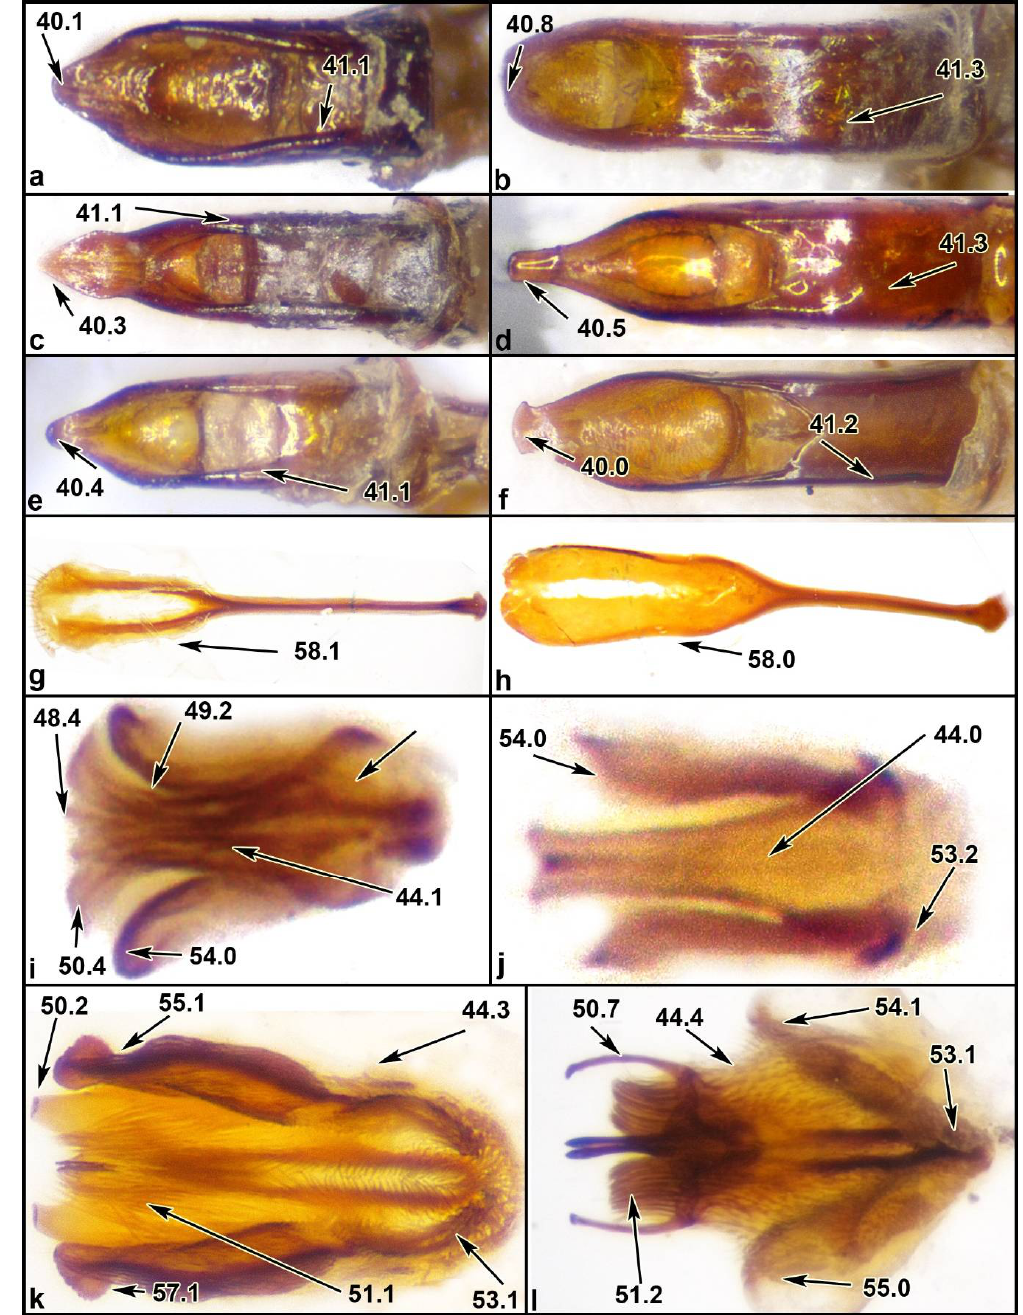
Figure 3. Penis of Dichotrachelus baldensis Barajon ( a ); D. cantabricus Franz, 1954 ( b ); D. meregallii Osella ( c ); D. devillei Osella ( d ); D. negrei Gonzanez ( e ); D. augusti F. Solari ( f ). Sternum VIII of female of D. sterlini Gredler ( g ); D. sulcipennis Stierlin ( h ). Male genital sclerite of D. baldensis ( i ); D. graellsii Perris ( j ); D. baudii (Seidlitz) ( l ); D. sulcipennis ( k ). 17. Pronotum, ratio length/width. 0 = transverse; 1 = subquadrate; 2 = longer than wide. 12. Shape of setae at base of scrobe, in front of eyes. 0 = elliptical; 1 = hair-like; 2 = oval; 3 = absent. 18. Pronotum, shape of median groove. 0 = not distinctly separated in anterior and posterior groove; 1 = distinctly divided into two grooves separated by a median relief. 13. Eyes, number of ommatidia. 0 ≥ 50; 1 ≤ 30; 2 = about 40. 14. Shape of setae on antennal scape. 0 = slender; 1 = spatulate; 2 = hair-like. 15. Shape of antennomere 1 of funicle. 0 = longer than wide; 1 = globose. 16. Shape of antennomere 2 of funicle: 0 = very slender; 1 = moderately longer than